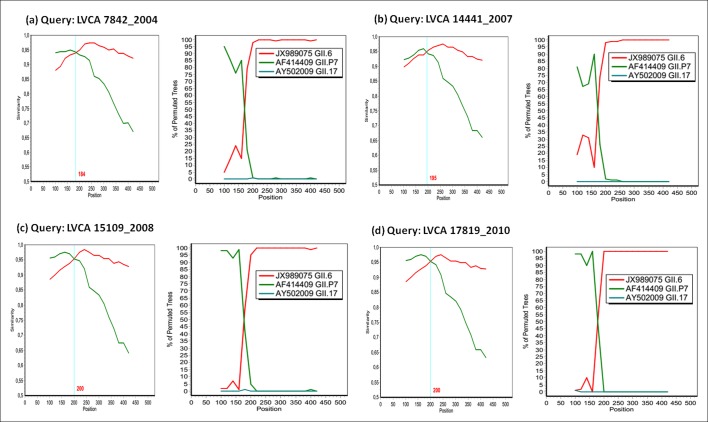
Simplot and Bootscan analyses of the NoV recombinant GII.P7/GII.6 detected in four different years.(a) LVCA7842, (b) LVCA14441, (c) LVCA15109, and (d) LVCA17819. For similarity plot, the y-axis gives the percentage of identity within a sliding window of 200 bp wide, with a step size between plots of 20 bp. The site where the two NoV parental strains of genotypes GII.6 (JX989075) and GII.7 (AF414409) have equal identity to the recombinant (crossed by the vertical blue lines) is the predicted site of recombination. For Bootscan, the y-axis gives the percentage of bootstrap support values of permutated trees using a sliding window of 200 bp wide with a step size between plots of 20 bp. GII.17 strain (AY502009) was used as an outlier sequence.